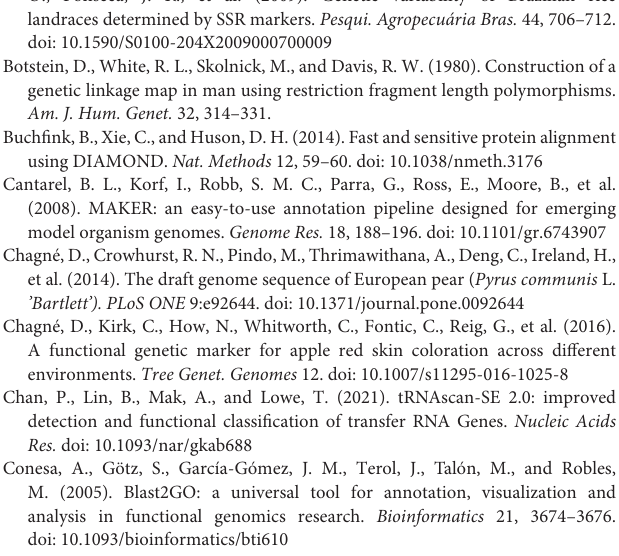
Figshare for the excel sheet as Data files can be found online at: